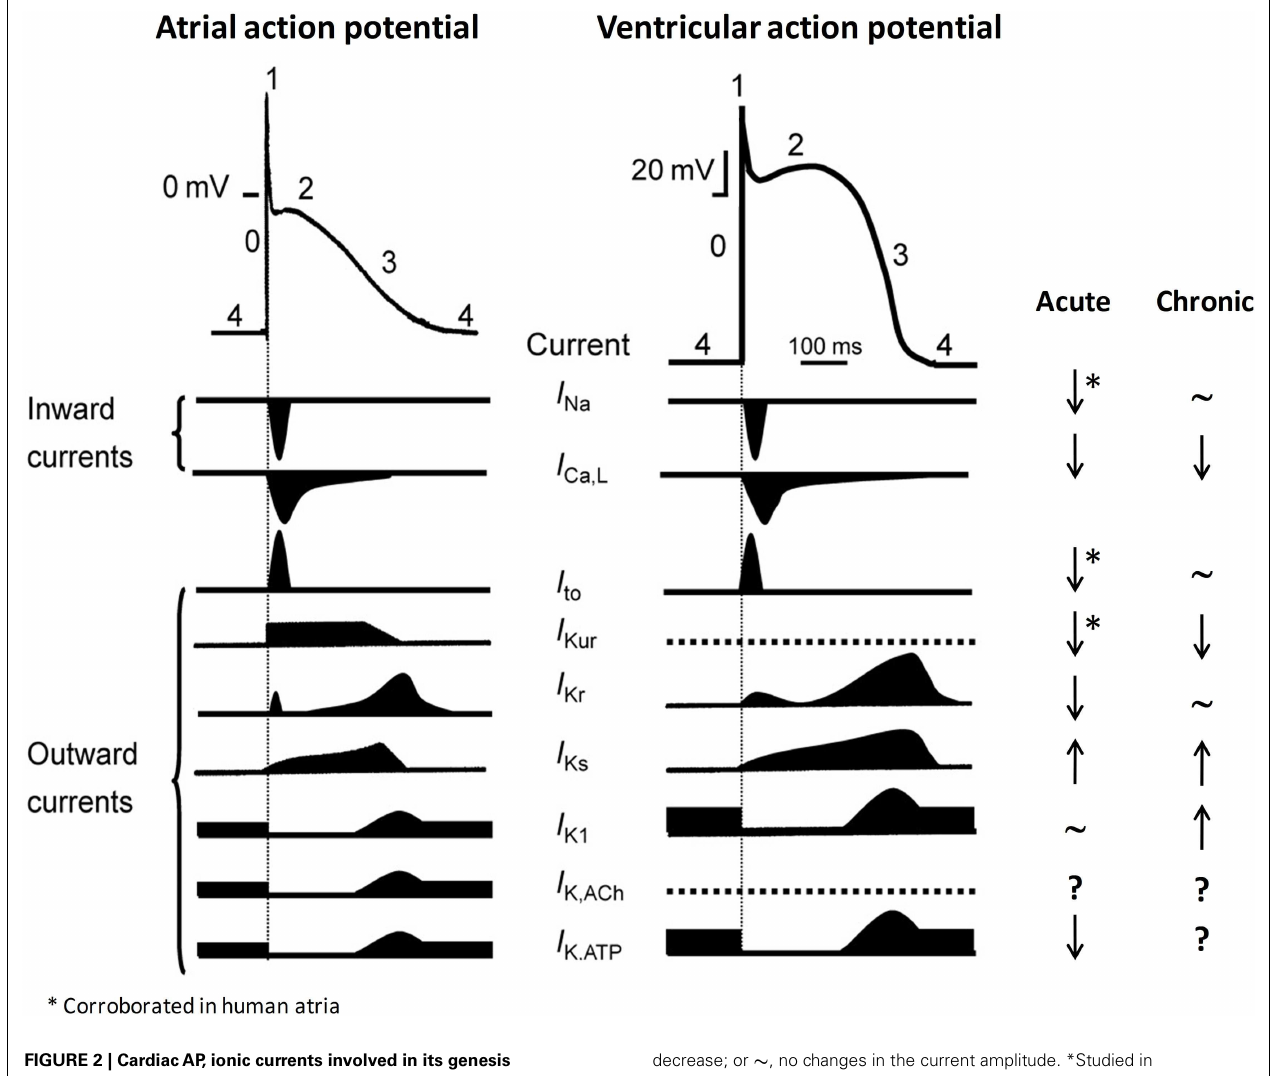
FIGURE 2 | CardiacAP, ionic currents involved in its genesis and maintenance, and the effects of n − 3 PUFAs on each current under acute and chronic conditions. ↑ , Increase; ↓ ,